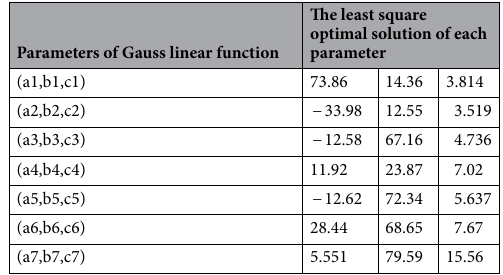
Parameters of Gauss linear function